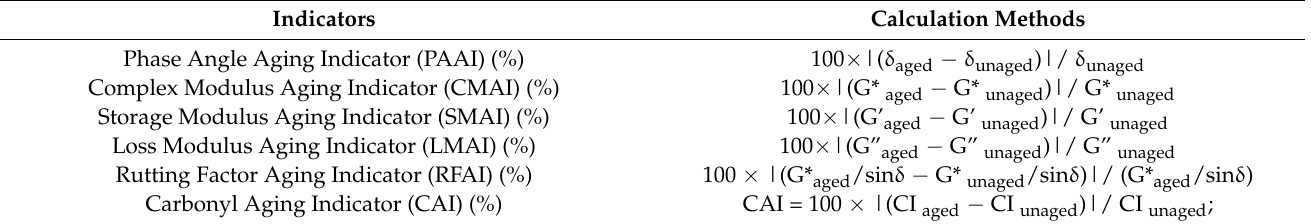
Table 3. Aging indicators in this